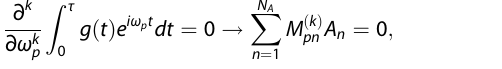
Fig. 2 Power-optimal pulse function g and spin-dependent force applied to an ion qubit. See Supplementary Note 4 for the relevant parameters of the sample case of fi ve qubits considered here. a Fourier-sine coef fi cients ∣ A n ∣ of the pulse function g ð t Þ ¼ τ = 300 μ s. The tails of ∣ A ∣ decay according to ~1/ n . The arrows indicate the locations of the mode frequencies. The signs of A n i.e., negative A n are depicted with orange and positive A n are depicted with gray. The top scale shows the basis frequencies n / τ , which are in resonance with the mode frequencies at the locations of the arrows. b Same as a but for a basis of 10,000 states. The main features occur at the same positions in n and in frequency, which shows convergence and basis independence. c Scaling of the maximal power, max t g ð t Þ as a function of the number of qubits N . Gate time τ = 500 μ s. Orange circles: numerical results, heuristic bound. Gray curve: analytic bound derived in Supplementary Note 5. d The time-dependent displacement in the phase space of ion number 1, where K = 0 (pink) and K = 3 (blue) are shown. The trajectories start and end at the